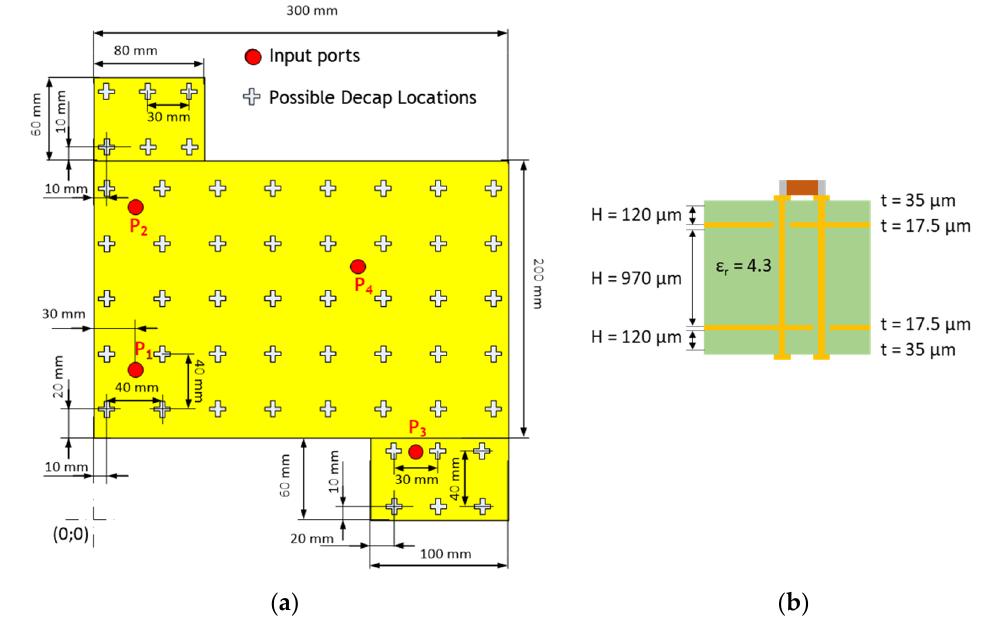
Figure 4. ( a ) The test power delivery network (PDN) boards and ( b ) its stack-up.